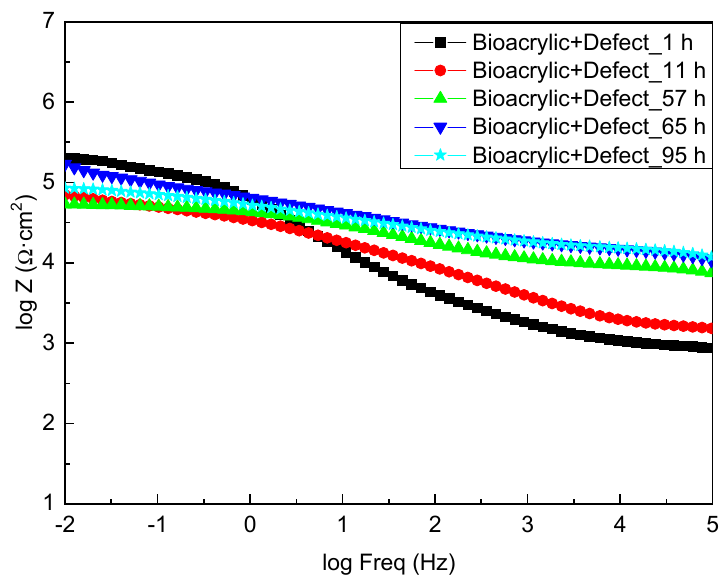
Figure 8. Bode plots of Bioacrylic binder with an artificial defect after different immersion time in 3.5 wt% NaCl solution.